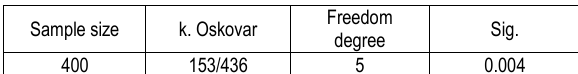
Table 9. Results of Friedman test (physical